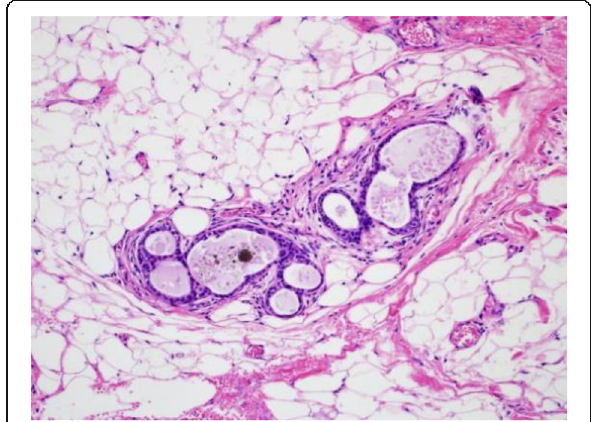
Fig. 4 Histopathological findings of the additional